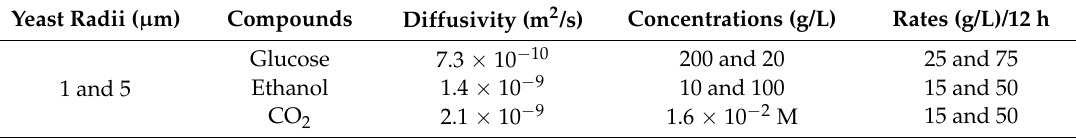
Table 1. Range of values used to calculate mass transfer resistances.